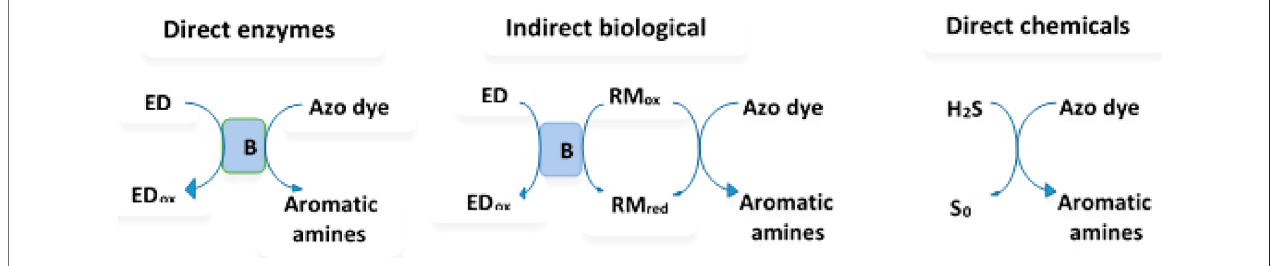
Frontiers in Physiology |